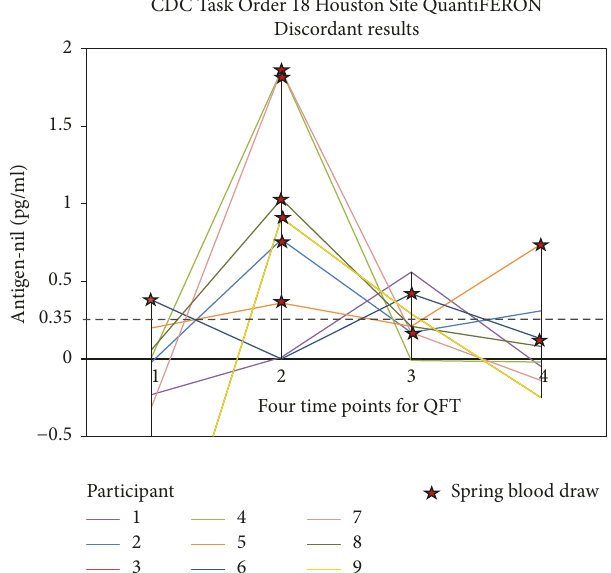
Figure 1: The results of the QFT of 9 out of the 28 individuals with serially discordant results are graphed here. A positive result is defined as an antigen response of 0.35 IU of IFN- 𝛾 or greater (after subtracting the IFN- 𝛾 measured in the nil QFT tube). The spring time points for each individual are identified with a star on the